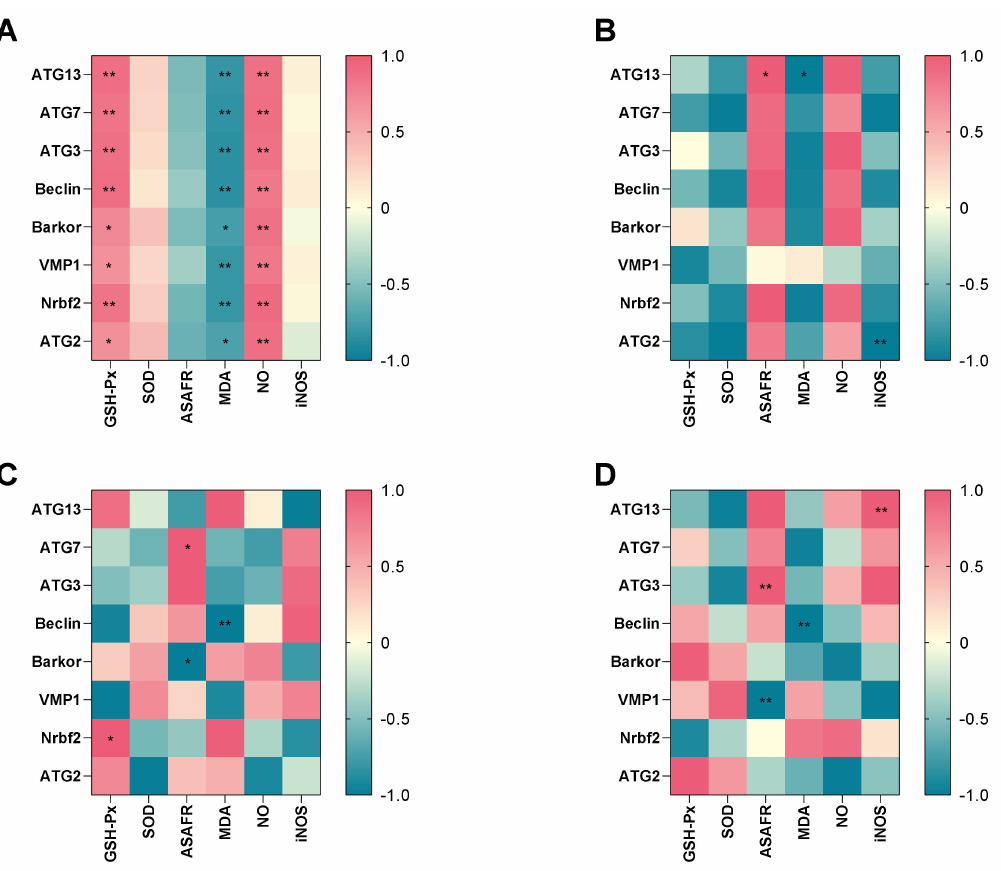
Figure 6. Correlation between antioxidant parameters and key different expression genes in hypotonic stress group. Note: ( A ): the correlation in hypotonic stress group; ( B ): the correlation in 7 dph larvae under hypotonic stress; ( C ): the correlation in 14 dph larvae under hypotonic stress; ( D ): the correlation in 21 dph larvae under hypotonic stress. The heat-map shows the Pearson correlation coefficient. The intensity of the colors represents the degree of association. * p < 0.05, ** p <